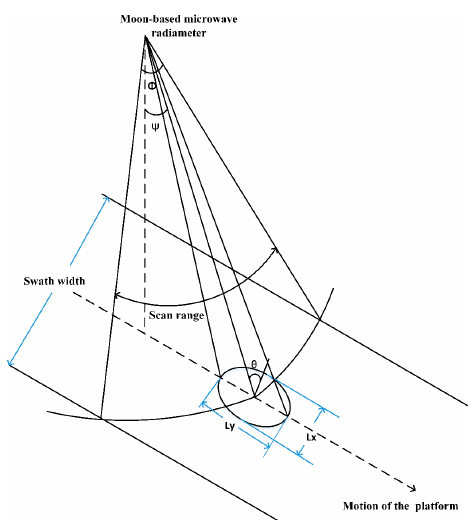
Figure 2. The scanning method of the Moon-based microwave radiometer (MBMR).